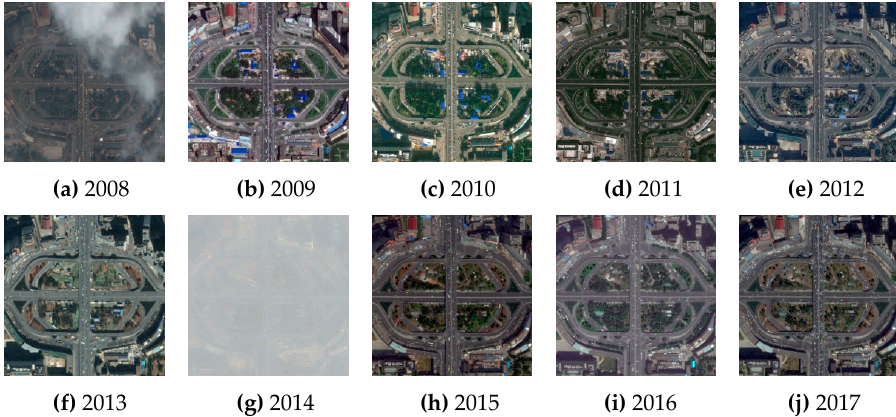
Figure 3. Multi-temporal Google Earth images of the same area from 2008 to 2017. Images are affected by complex background variations, including small rotation and translation, nonlinear geometric deformation, shadow, image quality degradation, and land cover changes. Factor 1: Rotation and translation. These factors are the most basic problems and should be estimated between reference and sensed images. In satellite images, rotation and translation errors